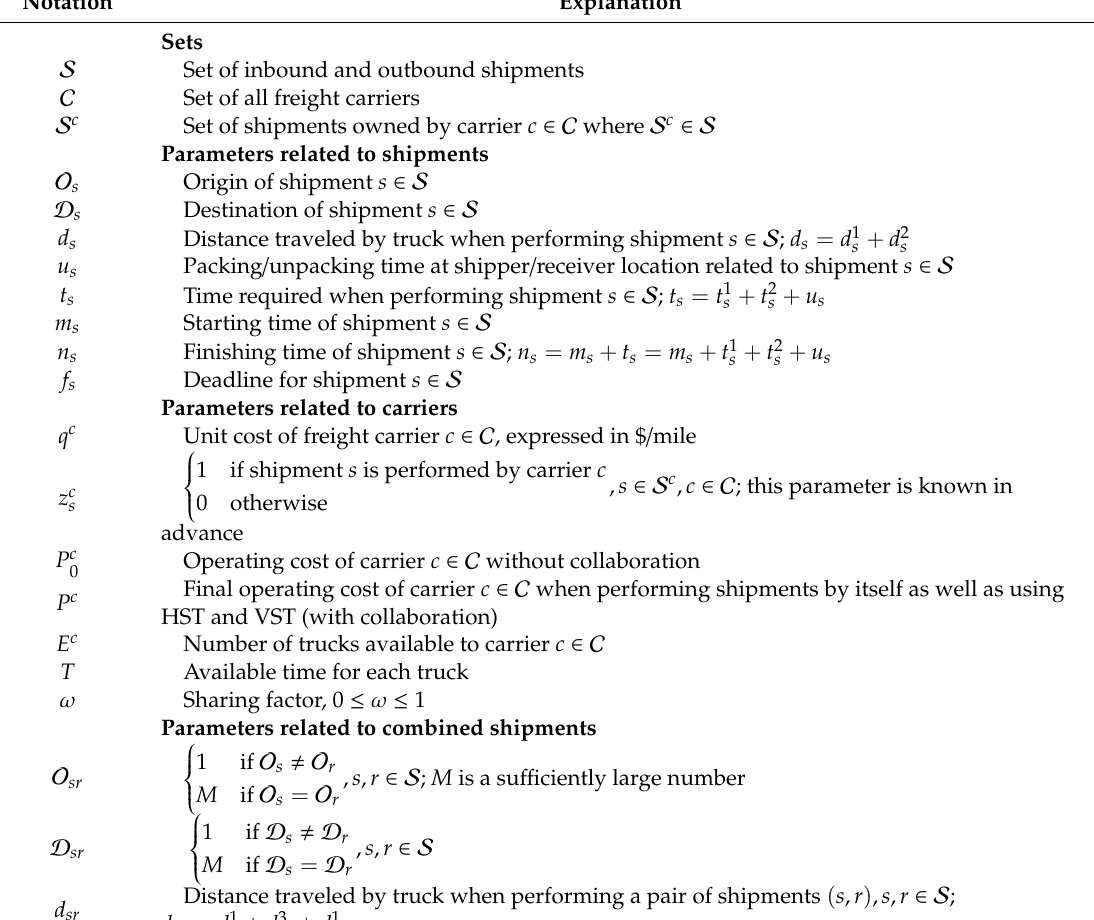
Table 3. Summary of mathematical